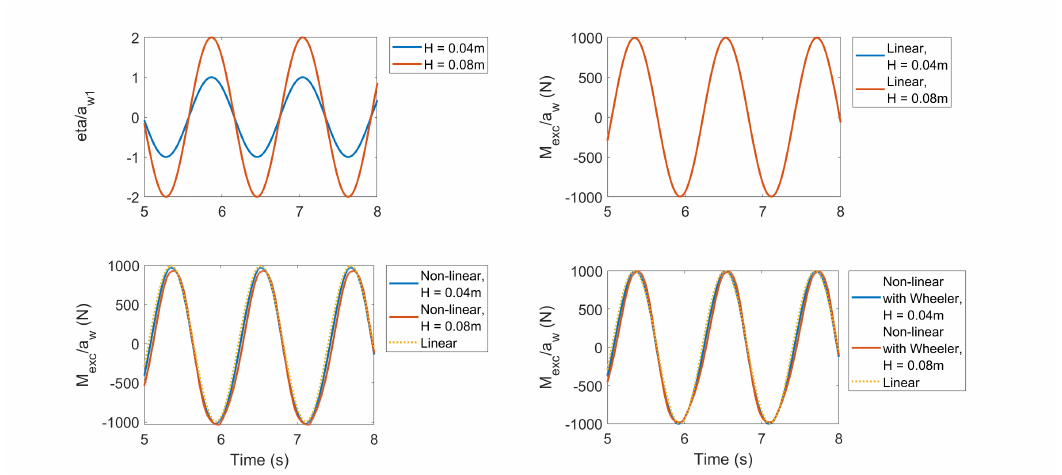
Figure 10. Zoomed normalized results from Figure 9a,b. The first figure shows the wave amplitudes normalized by the wave amplitude of the smaller wave ( a w 1 ), whereas the excitation moments, M exc are normalized by the corresponding wave amplitudes that originated them.